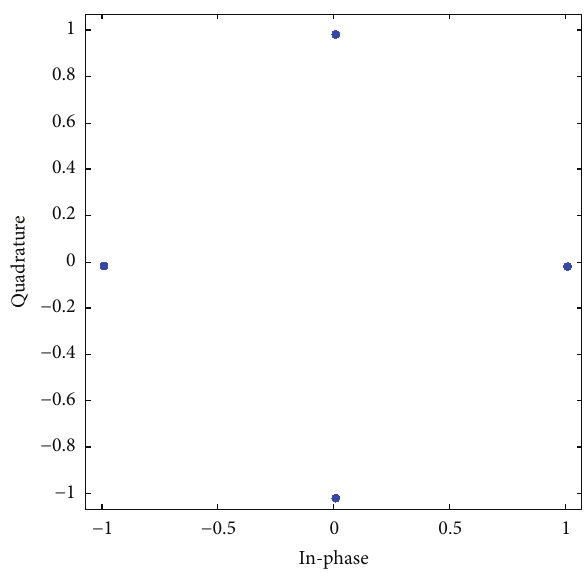
Figure 12: Transmitted symbols scatter plot for 𝑀 = 4 .